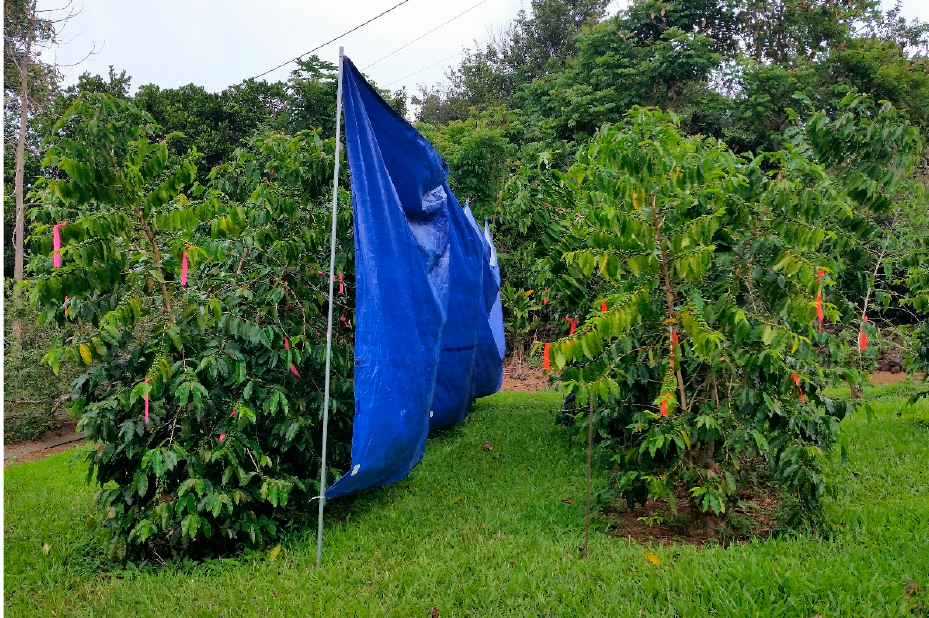
Figure 3. A physical barrier was erected between treatment plots to avoid drift and cross-contami- nation. These barriers were removed following the spray